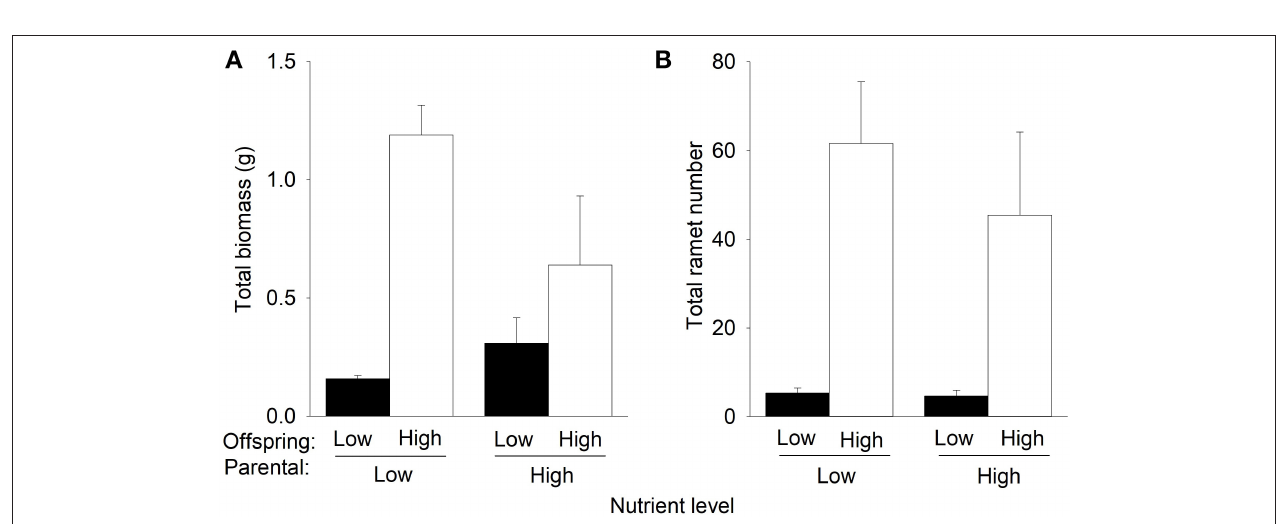
FIGURE 5 | Effects of parental nutrient level and offspring nutrient level on (A) total biomass and (B) total ramet number of Pistia stratiotes produced by the F3 offspring ramets in the second phase of the experiment. Bars show means +